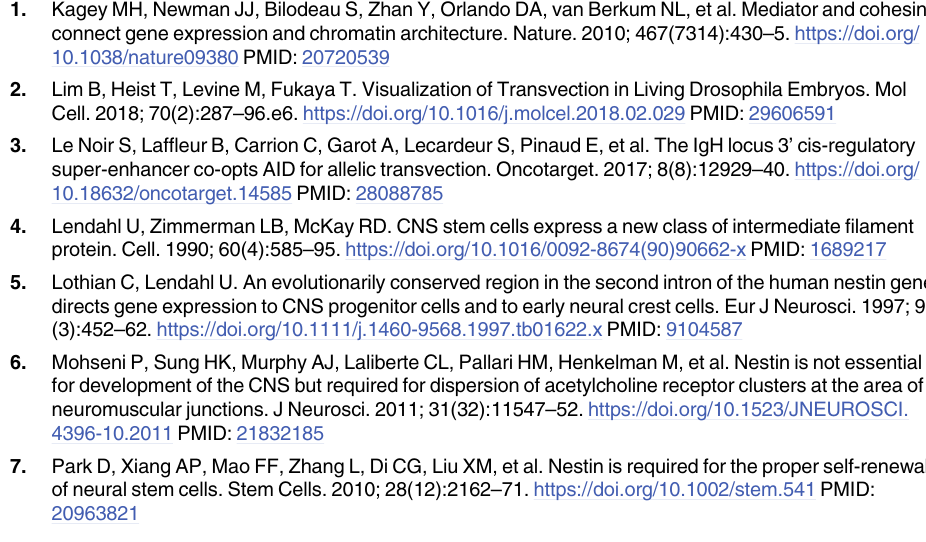
S3 Fig. Nestin vasculature phenotype in neural tube. Nestin and CD31 expression within a 10.5dpc neural tube section. Within the WT sample no overlap is seen between CD31 and NES, while the -255/-255 sample shows co-localisation between the two proteins. (PNG) S4 Fig. Nestin knockout mutation information. The Nestin ‘Big Deletion’ and ‘Frameshift Mutations’ generated by CRISPR. A. The FS mutation comprises an 8 bp deletion shown in red. B. The chromatogram file of the mutation. C. The amino acid sequence of the mutations generated by the FS mutation. D. The chromatogram file of the ‘Big Deletion’ incorporates an 8.6kb deletion that has been minimised for visualisation. E. The amino acid sequence of the BD mutation. The large 1824AA sequence within the WT sequence is not shown.